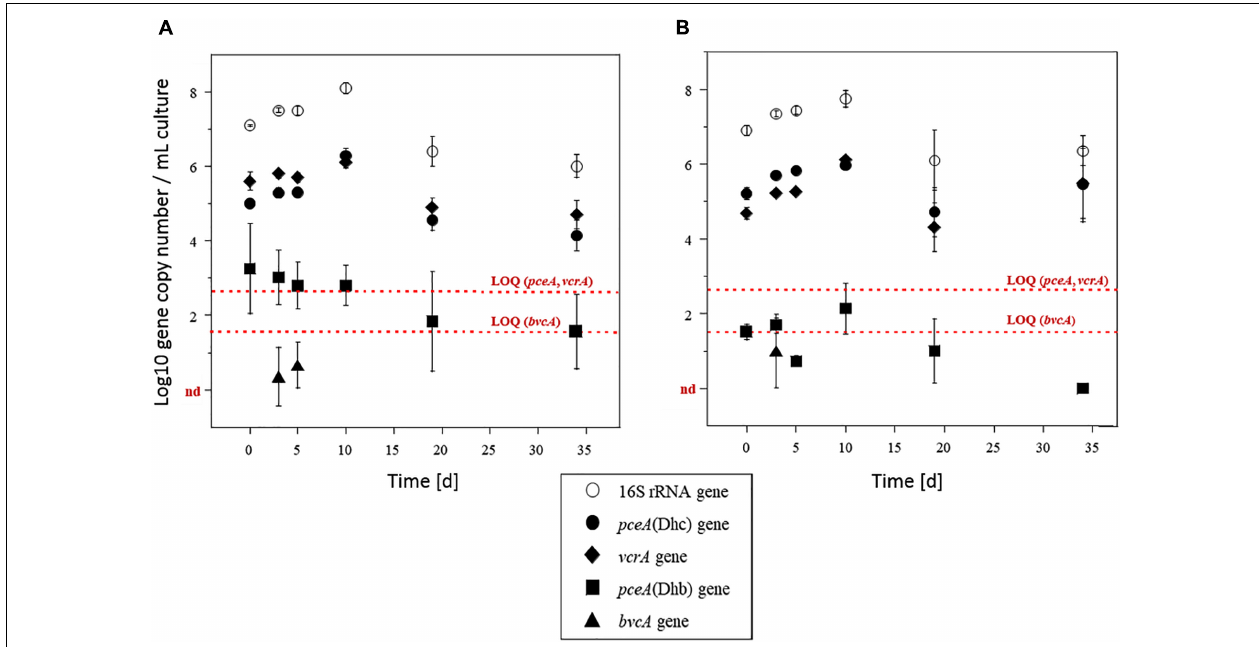
FIGURE 4 | Biomarker genes in microcosms. Quantification of 16S rRNA gene (white circles), pceA (Dhc) (diamonds), pceA (Dhb) (squares), vcrA (black circles) and bvcA (triangles) genes in microcosms amended with acetate and spiked with 10 µ M (A) or 100 µ M (B) PCE. The tceA gene was not detected. Values represent the mean ( ± standard deviation) of three replicates. Quantification limits of qPCR analysis for functional genes are indicated by red lines. nd, not detected.